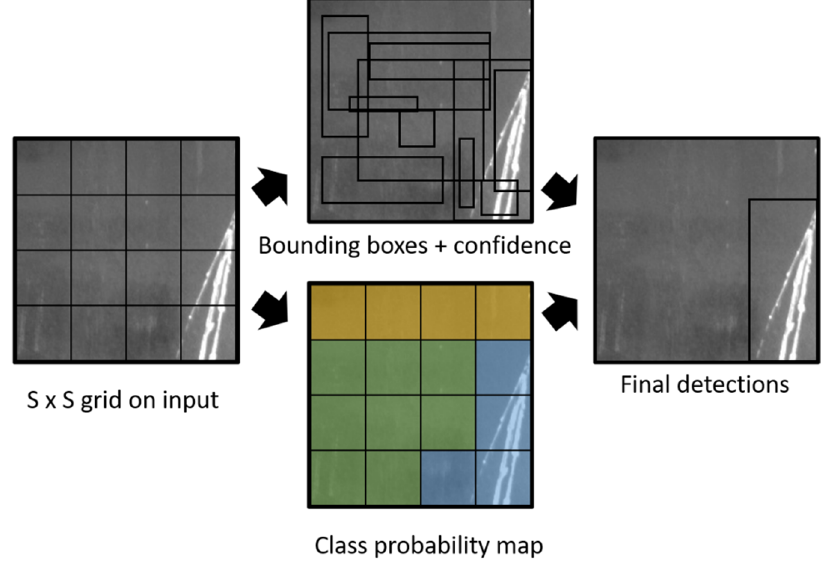
Figure 1. The overview of the YOLO algorithm.